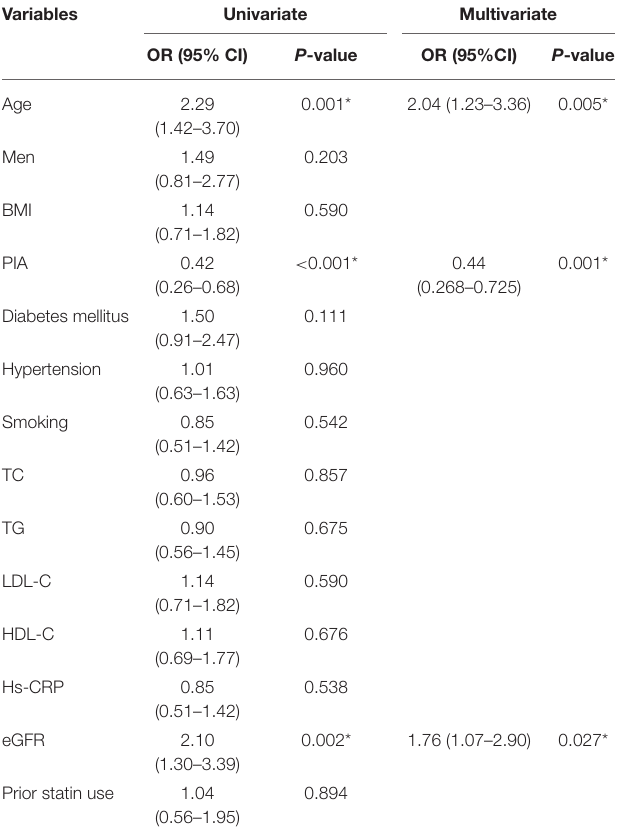
TABLE 4 | The logistic regression analysis of plaque rupture.